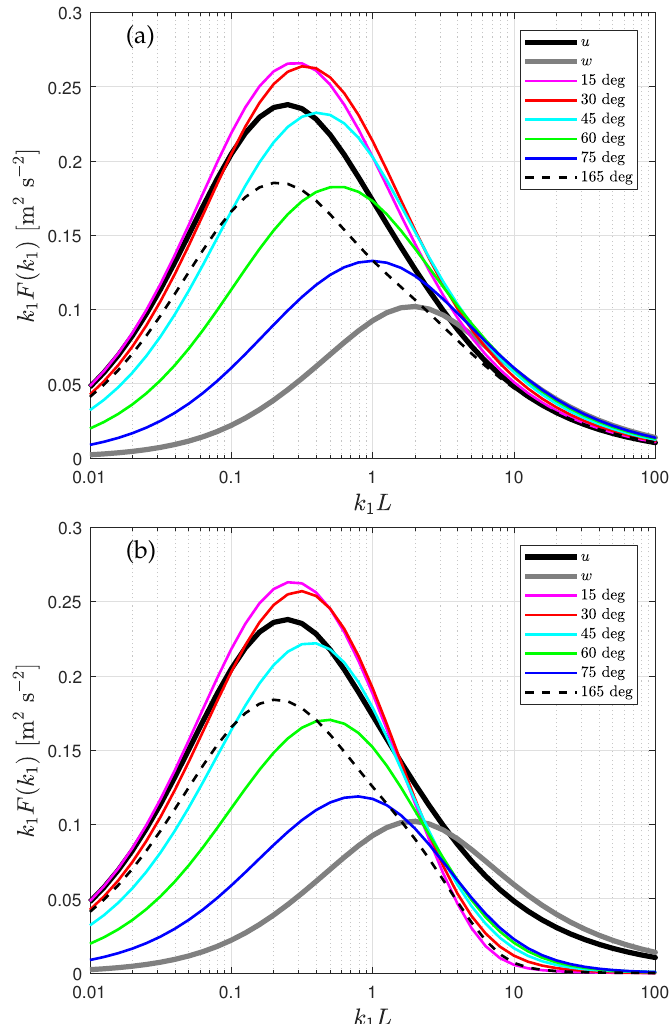
Figure 2. Simulated u - and w -velocity spectra and radial velocity spectra of a lidar with ( a ) and without ( b ) the effect of filtering for different elevation angles with respect to the mean wind for α(cid:101) 2/3 = 0.1 m 4/3 s − 2 , L = 50 m, and Γ = 3. For the case of filtering (b), z R / L =